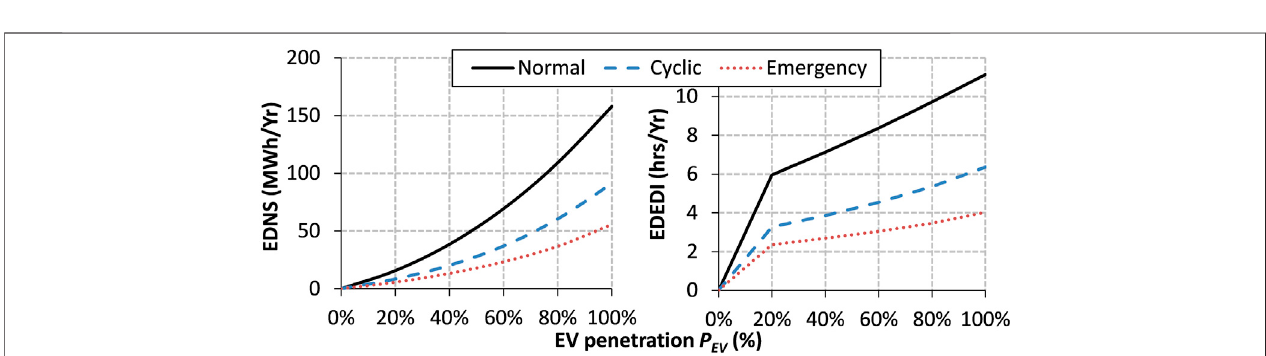
FIGURE 6 | EDNS and EDEDI output of Sc-4 when utilizing normal, cyclic and emergency ratings.